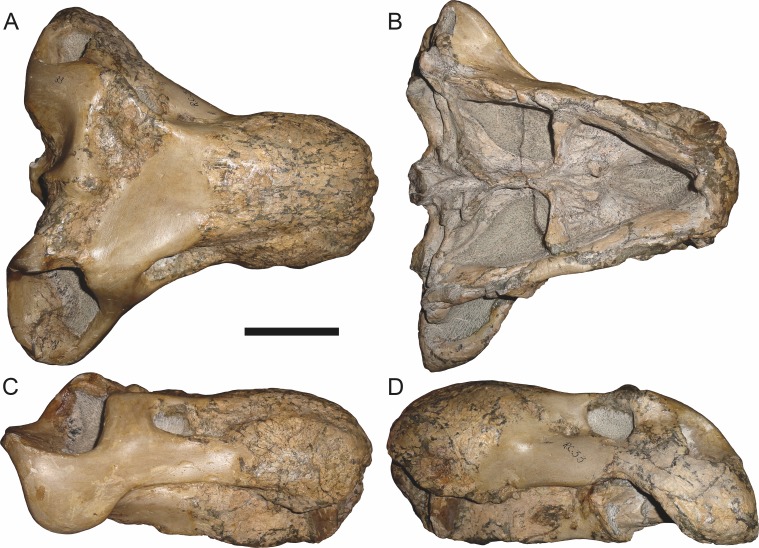
Referred skull (RC 33) of Rubidgea atrox
Broom, 1938 in (A) dorsal, (B) ventral, (C) right lateral, and (D) left lateral view.Holotype of Rubidgea laticeps
Broom, 1940b. Scale bar equals 10 cm.